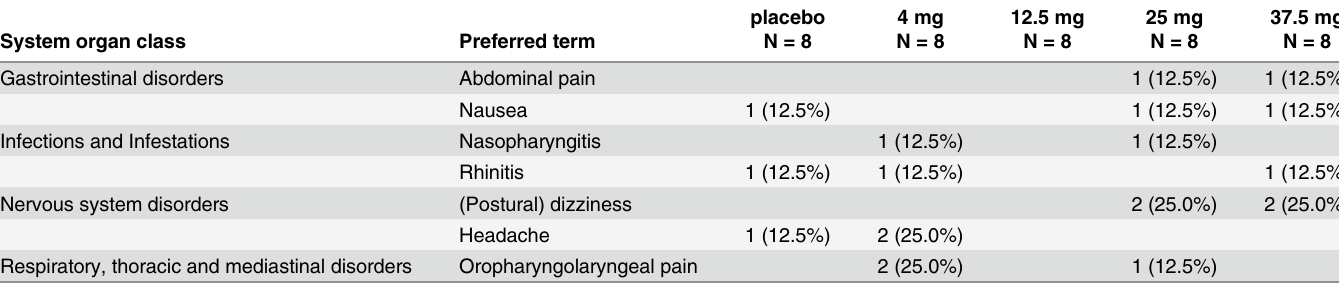
Table 1. Treatment-emergent adverse events occurring during the Phase I study in at least two different subjects following a single dose of HspB5.